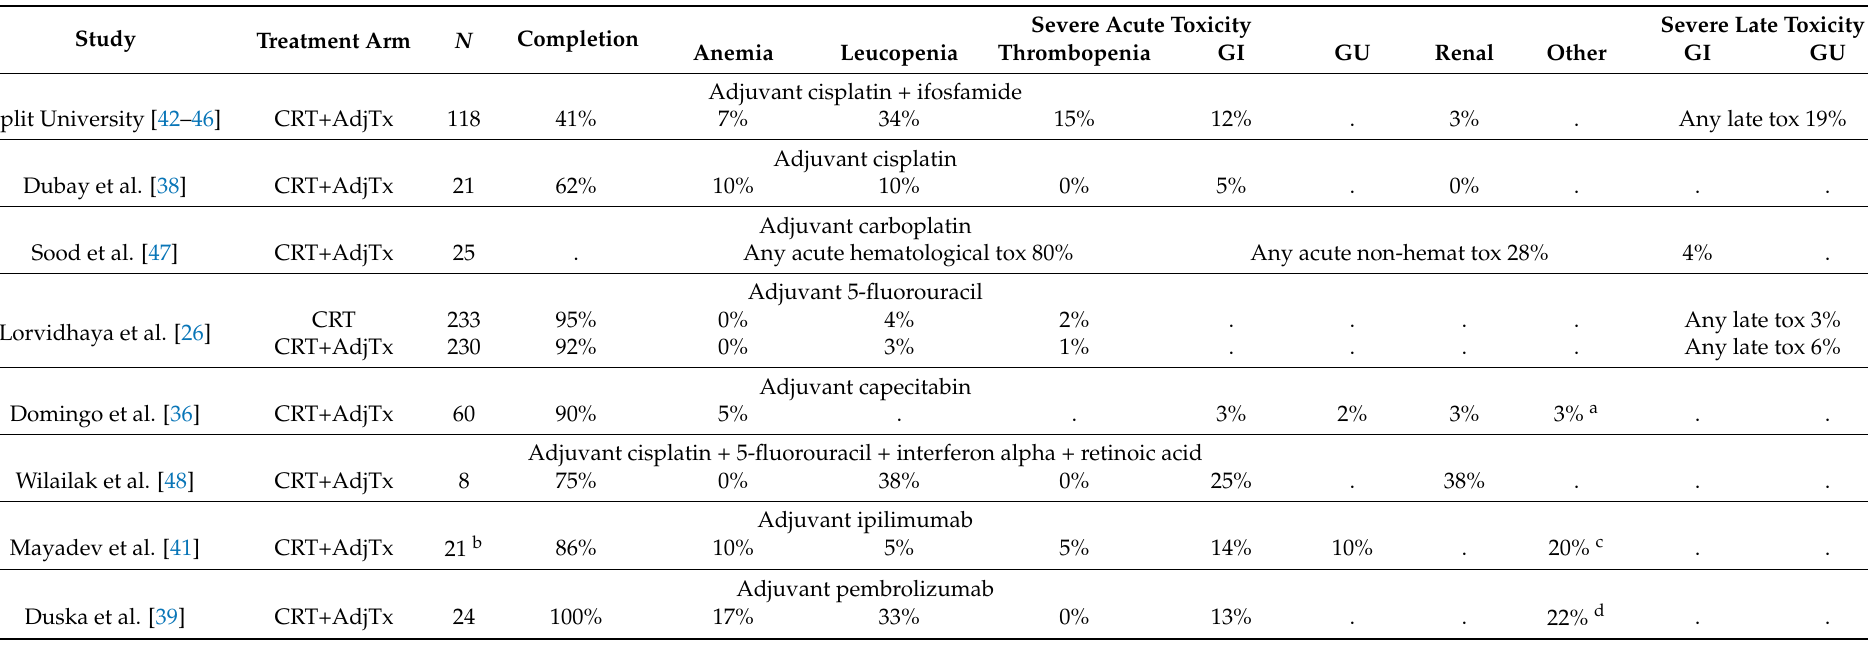
Table 5. Feasibility and severe toxicity of other adjuvant systemic